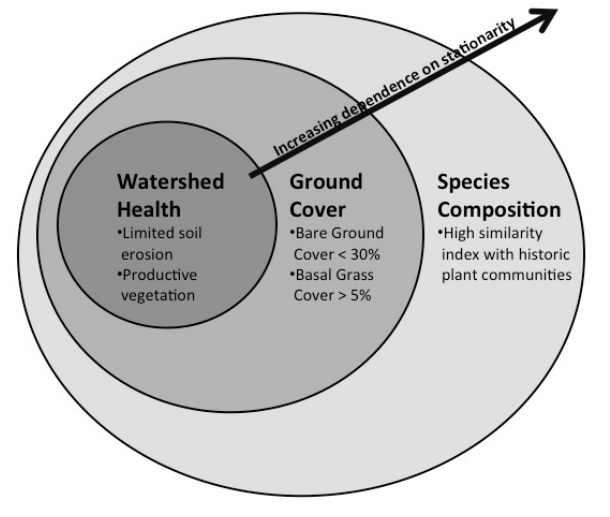
Fig. 5 . An example of nested resource